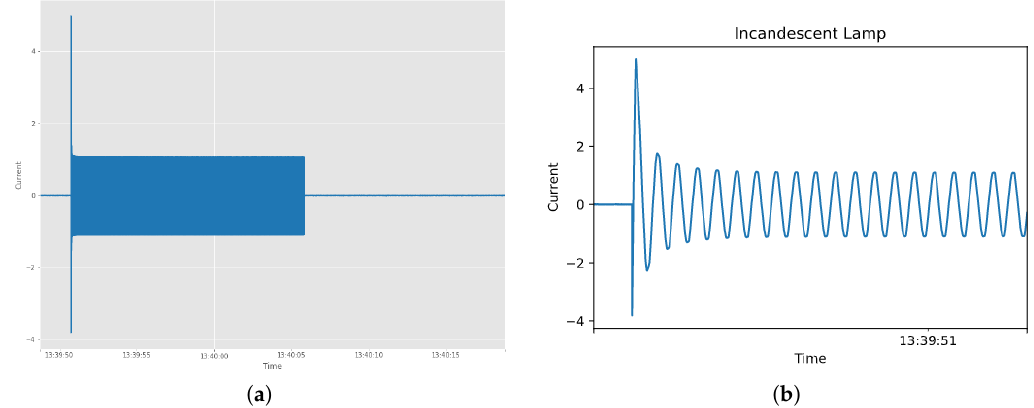
Figure 11. A LIT-Dataset waveform of an incandescent lamp presented in NILMTK. ( a ) Complete waveform. ( b ) Image zoomed into power-ON